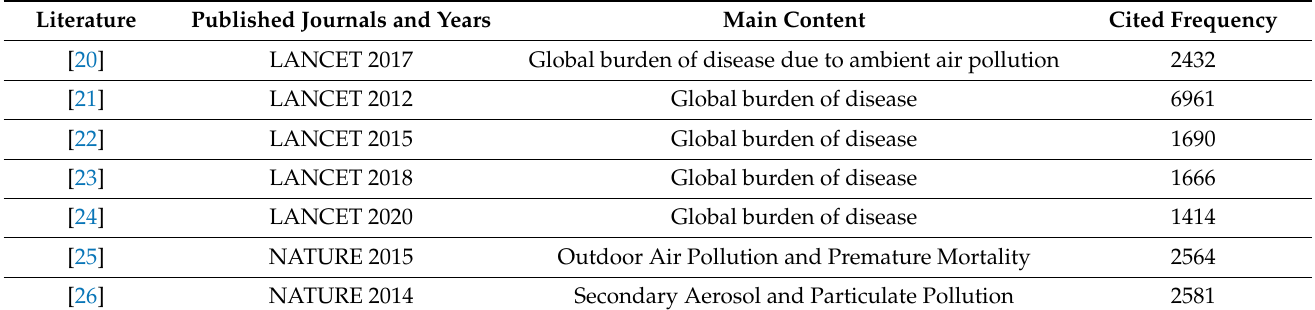
Table 3. Highly cited English